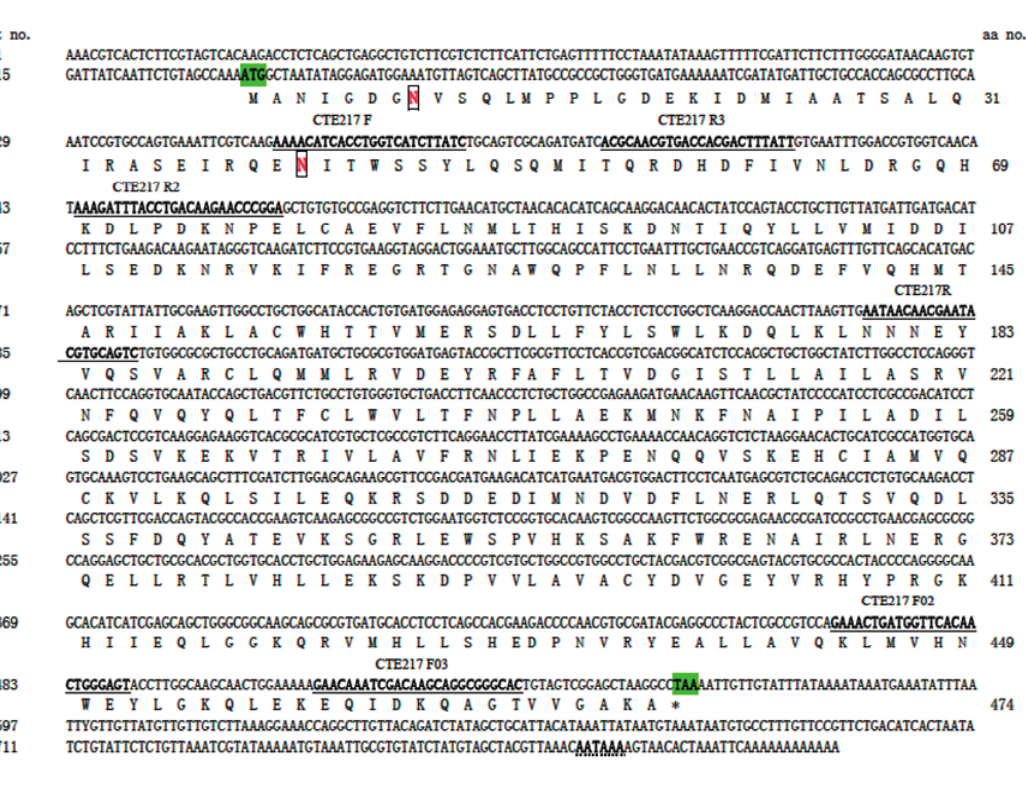
Figure 1. The full-length cDNA sequence of MsV1H and deduced amino acid sequence. The start and stop codon are in green, and putative polyadenylation signal sequences are indicated by a dotted line. Primers were labeled and unlined. Two potential Asn-linked glycosylation sites were